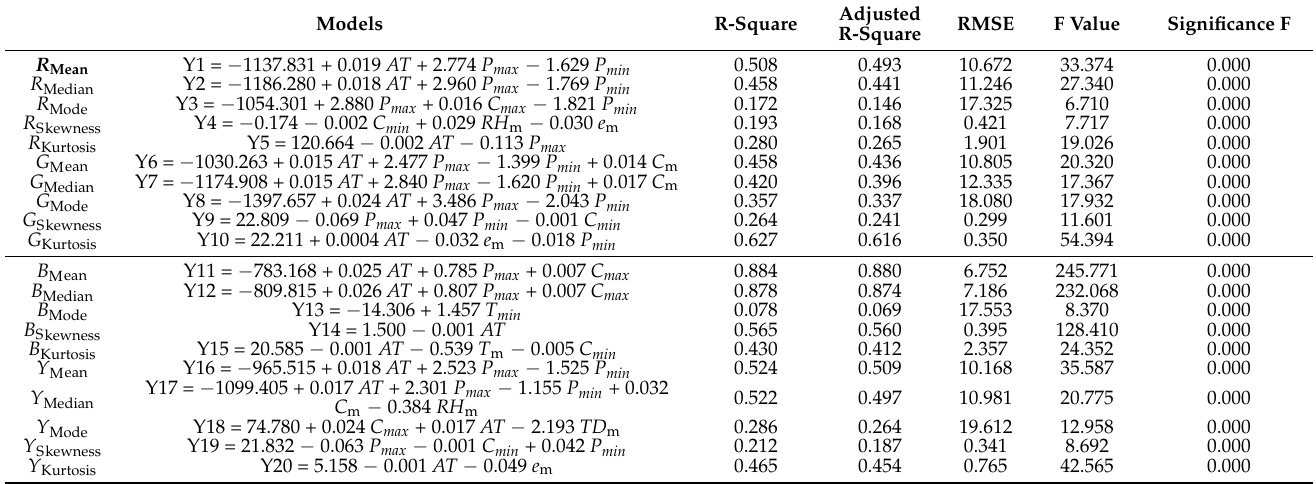
Table 1. Canopy leaf color response regression models of pepper and their goodness of fit. Models